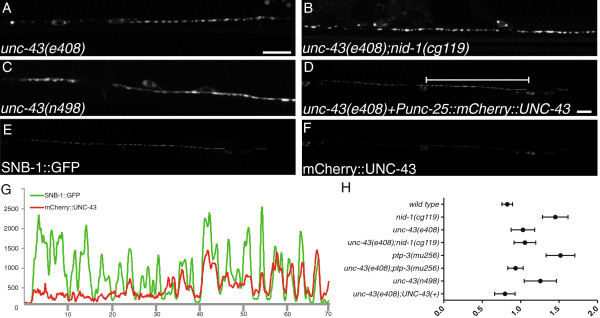
unc-43 can cell autonomously regulate presynaptic morphology. (A) The unc-43(e408) loss-of-function (LOF) mutation caused an increase in puncta size. (B) The e408 mutation suppressed the morphological defects found in the nid-1 background. (C) The n498 gain-of-function (GOF) mutation in unc-43 caused enlarged puncta that were disorganized. (D-F) Expression of an mCherry-tagged UNC-43 chimera specifically in the GABAergic neurons largely rescued the SNB-1::GFP morphology defects present in e408 animals. (G) A line scan of the VD12 axon region (line in panel D) demonstrating the co-incidence of mCherry::UNC-43 (red) with SNB-1::GFP (green). GFP/RFP coincidence was measured in a single confocal slice. (H) A plot of the puncta area measured by genotype as mean (circle) with the 5 to 95% confidence interval (whiskers). All animals in these micrographs are young adults (1 to 2 days post 4th larval stage (L4)).